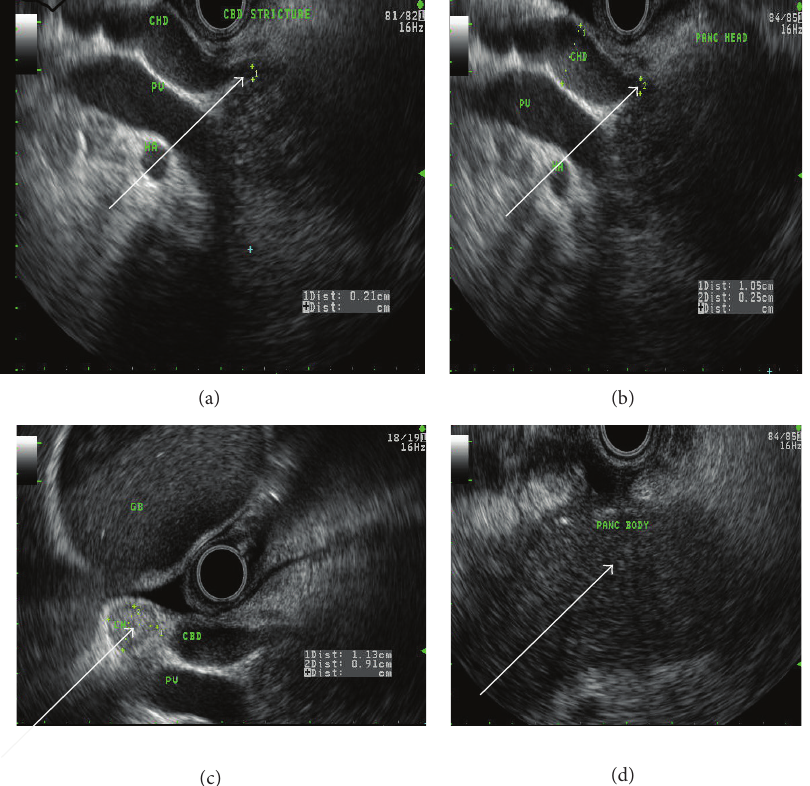
Figure 2: Endoscopic ultrasound images arrows showing (clockwise) (a) CBD stricture, (b) dilated CHD, (c) reactive lymph node, and (d) homogenous pancreatic